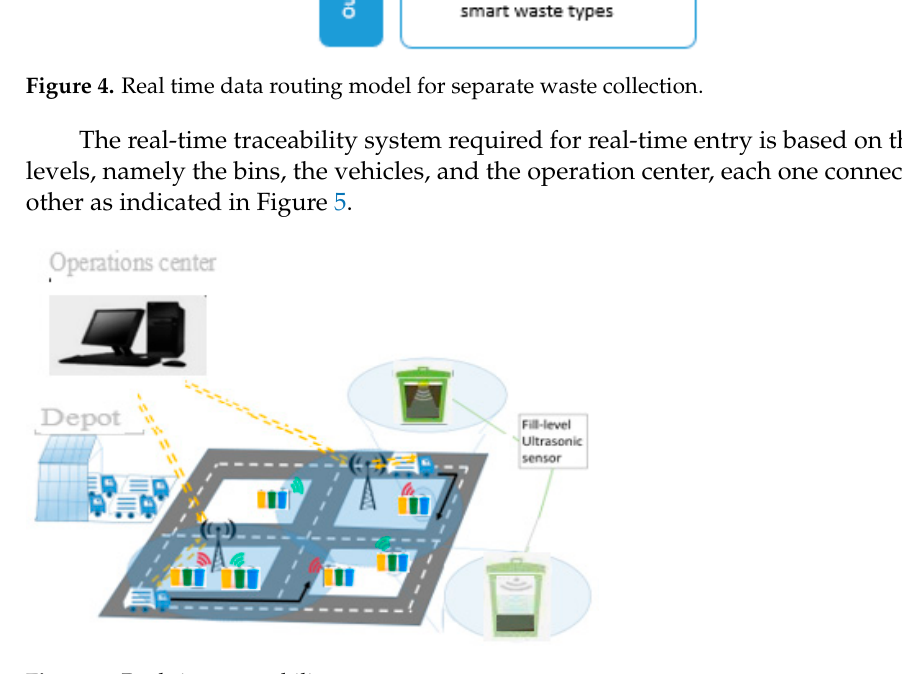
Figure 4. Real time data routing model for separate waste collection.